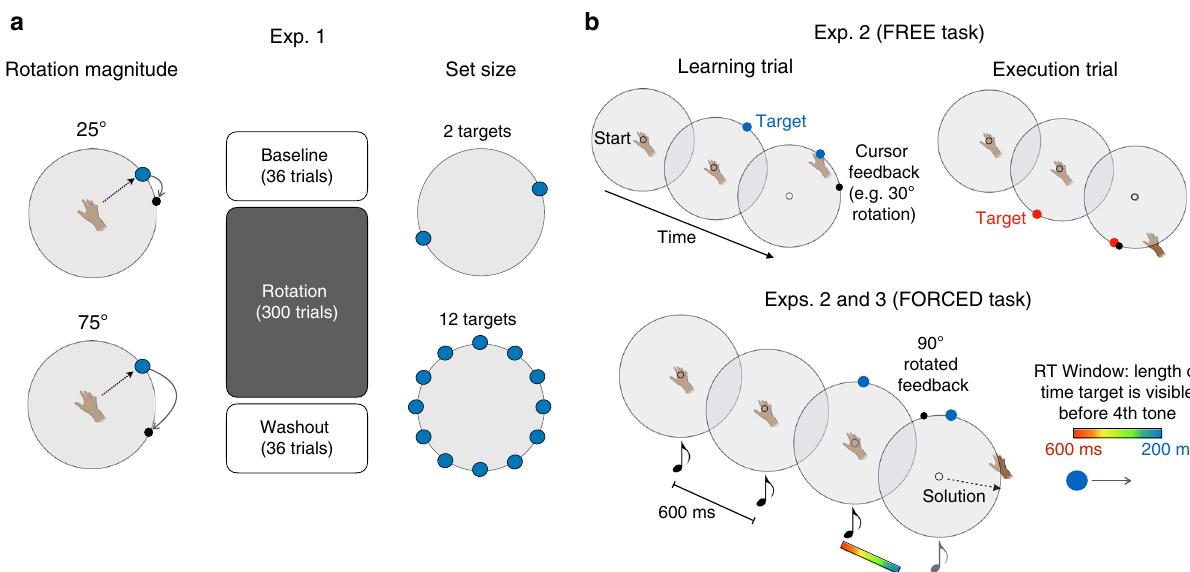
Fig. 1 Experiment 1 – 3 task design. a Experiment 1: subjects performed a standard visuomotor rotation task, attempting to land a rotated visual cursor on a target. A between-subjects, 2 × 2 design was used, crossing the factors Rotation Magnitude (the size of the rotation in the rotation block; left) and Set Size (the number of possible target locations in the task; right). b Experiments 2 – 3: FREE task: subjects performed trial pairs consisting of learning trials (left) and execution trials (right). Thirteen rotation sizes were pseudorandomly presented ( − 90 ˚ :15 ˚ :90 ˚ ). FORCED task: subjects were required to initiate their movement after target presentation and <100 ms after the fourth tone. Targets could appear in either 1 of 12 locations (Exp. 2) or 1 of 2 locations (Exp. 3). The time of target appearance was titrated to induce subjects to react with a distribution of